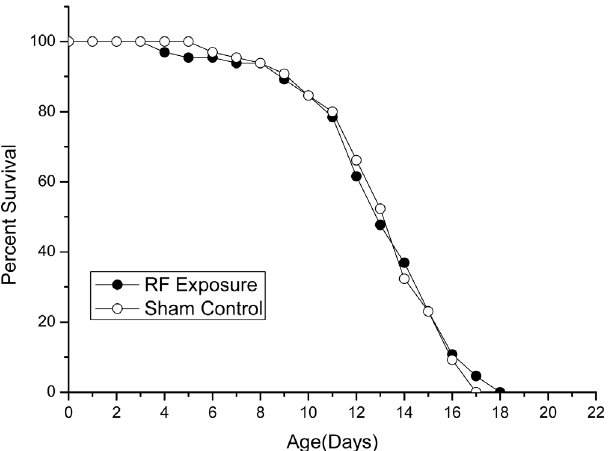
Fig 2. The longevity curve of RF exposure group and sham control groups. The significance levels ( P- value) were analyzed between RF exposure and sham control group and were non-significant ( P =